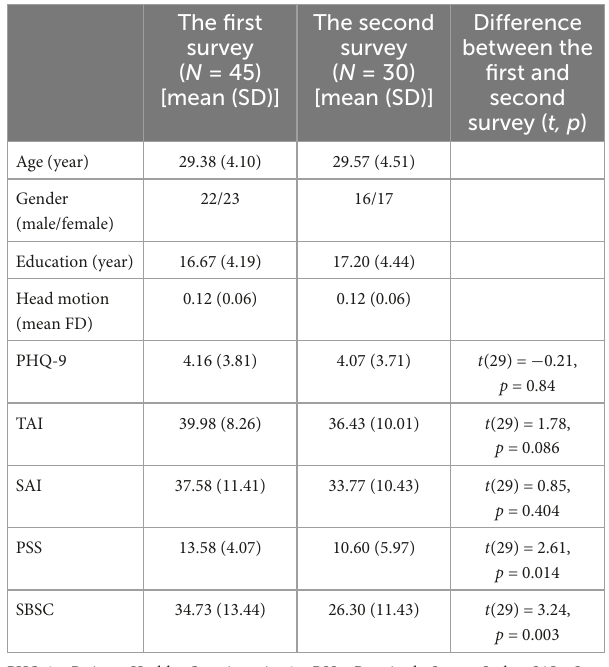
one time point before, and the 12 corresponding squared